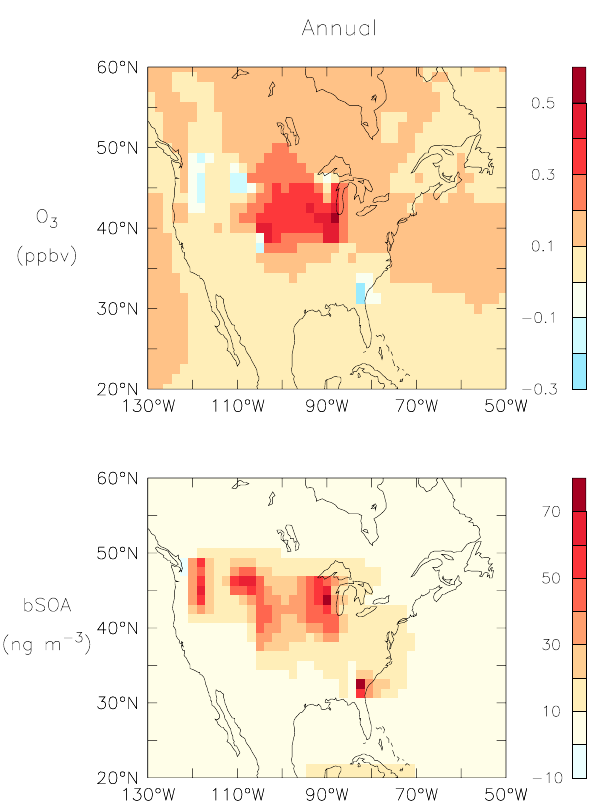
Fig. 5. Differences in annual mean surface concentrations of ozone (top) and SOA (bottom) for N America for SRC vs.